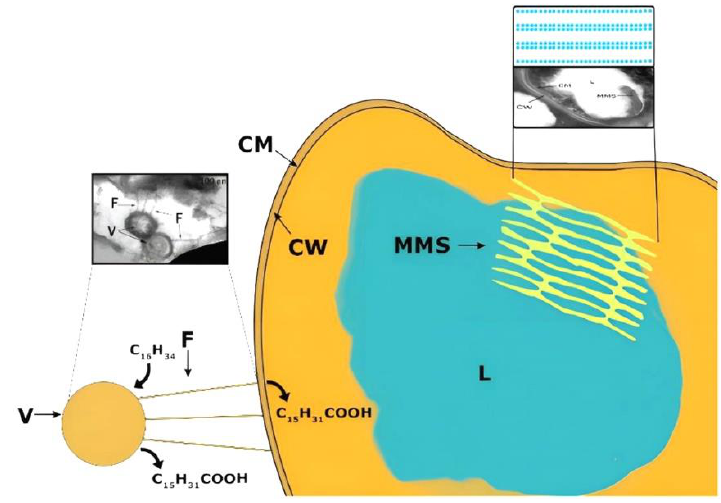
Figure 6. Mechanisms of hexadecane transformation by Rhodococcus bacteria.